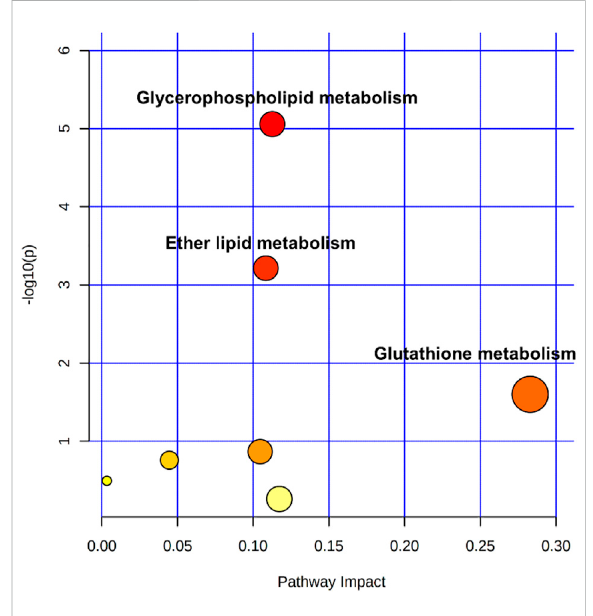
FIGURE 7 Pathway analysis overview depicting altered metabolic pathways in NCI-H1299 cells from control and COJEH/ZOJEH- treated groups. The metabolic pathways are displayed as distinctly colored circles depending on their enrichment analysis scores (vertical axis, shade of red) and topology (pathway impact, horizontal axis, circle diameter) via MetaboAnalyst